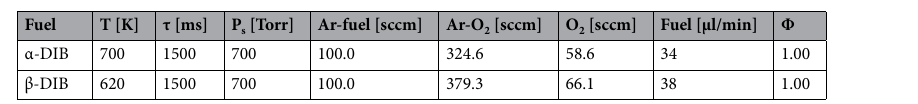
Table 1. Flow configuration for experiments using α- and β-diisobutylene (DIB).